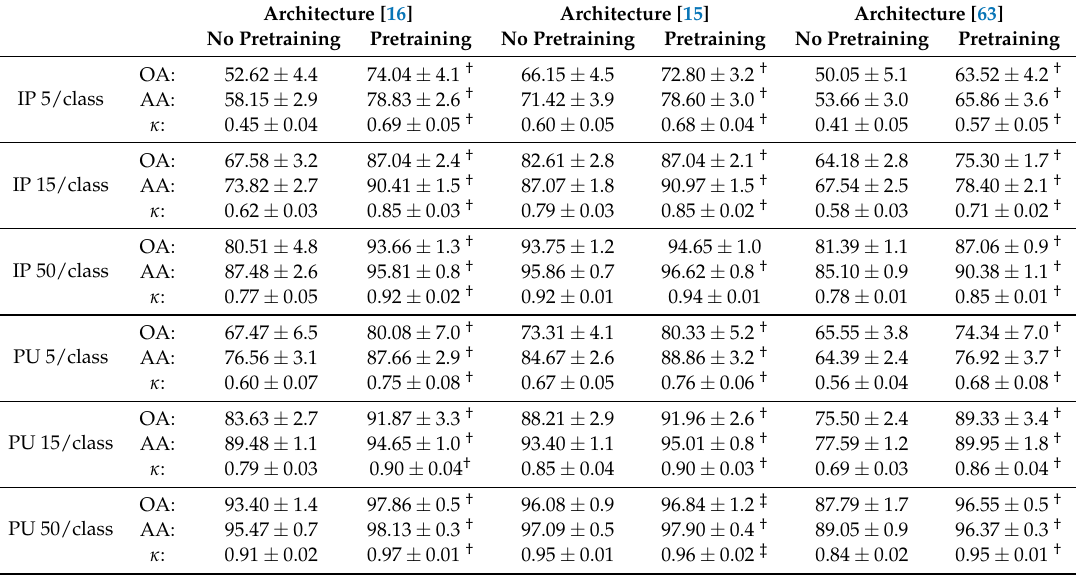
Table 1. The result of the first experiment. Each row presents Overall Accuracy (OA), Average Accuracy (AA), and Cohen’s kappa ( κ ) for given scenario. IP denotes the Indian Pines dataset, PU the Pavia University; further differentiation is for number of samples per class in fine-tuning. Accuracies are given as averages with standard deviations with and without pretraining for the three investigated network